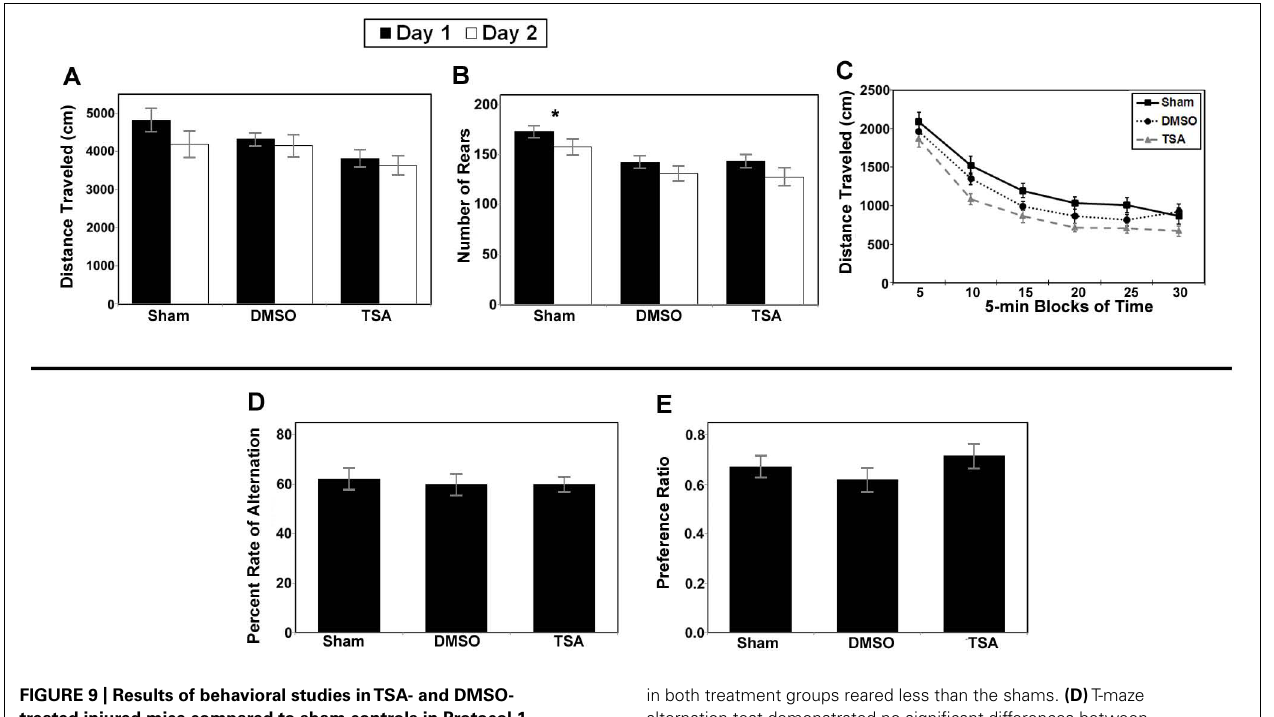
in both treatment groups reared less than the shams. (D) T-maze alternation test demonstrated no significant differences between the groups. (E) Novel object testing also demonstrated no significant differences (* p <